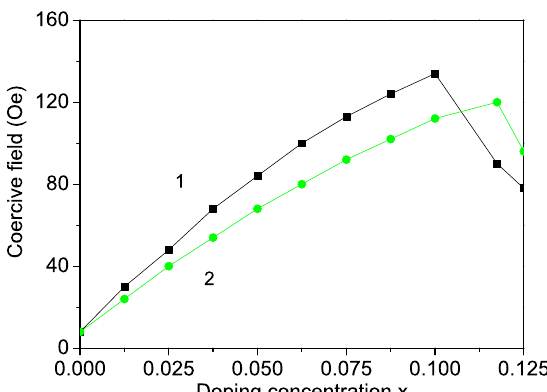
Figure 5. Doping concentration dependence of the coercive field of a MgO NP for d = 20 nm, T = 315 K for different doping ions: (1) Fe and (2) Co ion